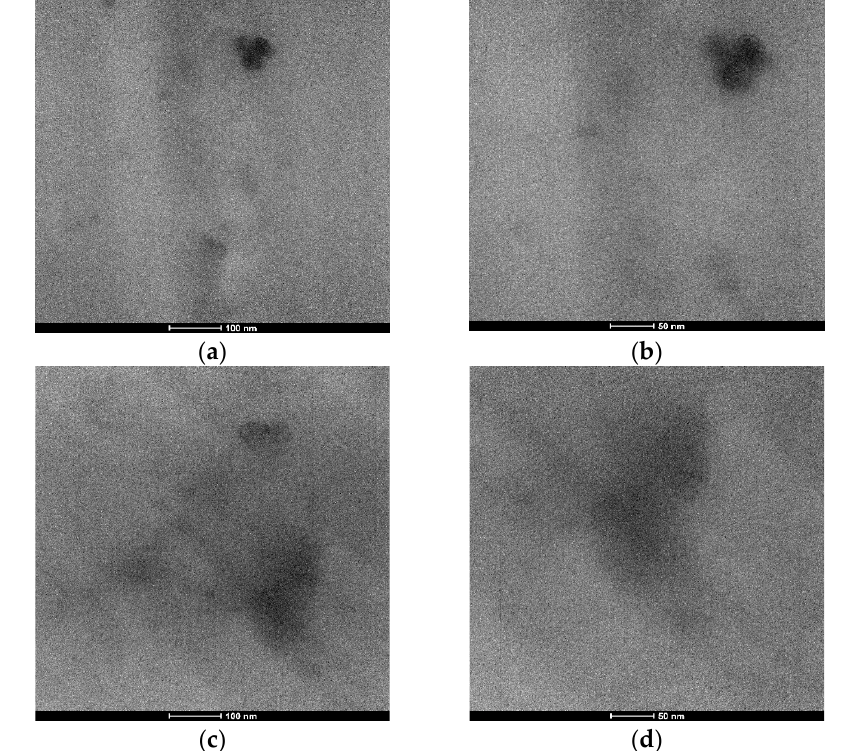
Figure 3. Typical TEM micrographs for ( a , b ) BOMF/MNA_2Si and ( c , d ) DGEBA/MNA_2Si at different magnifications.